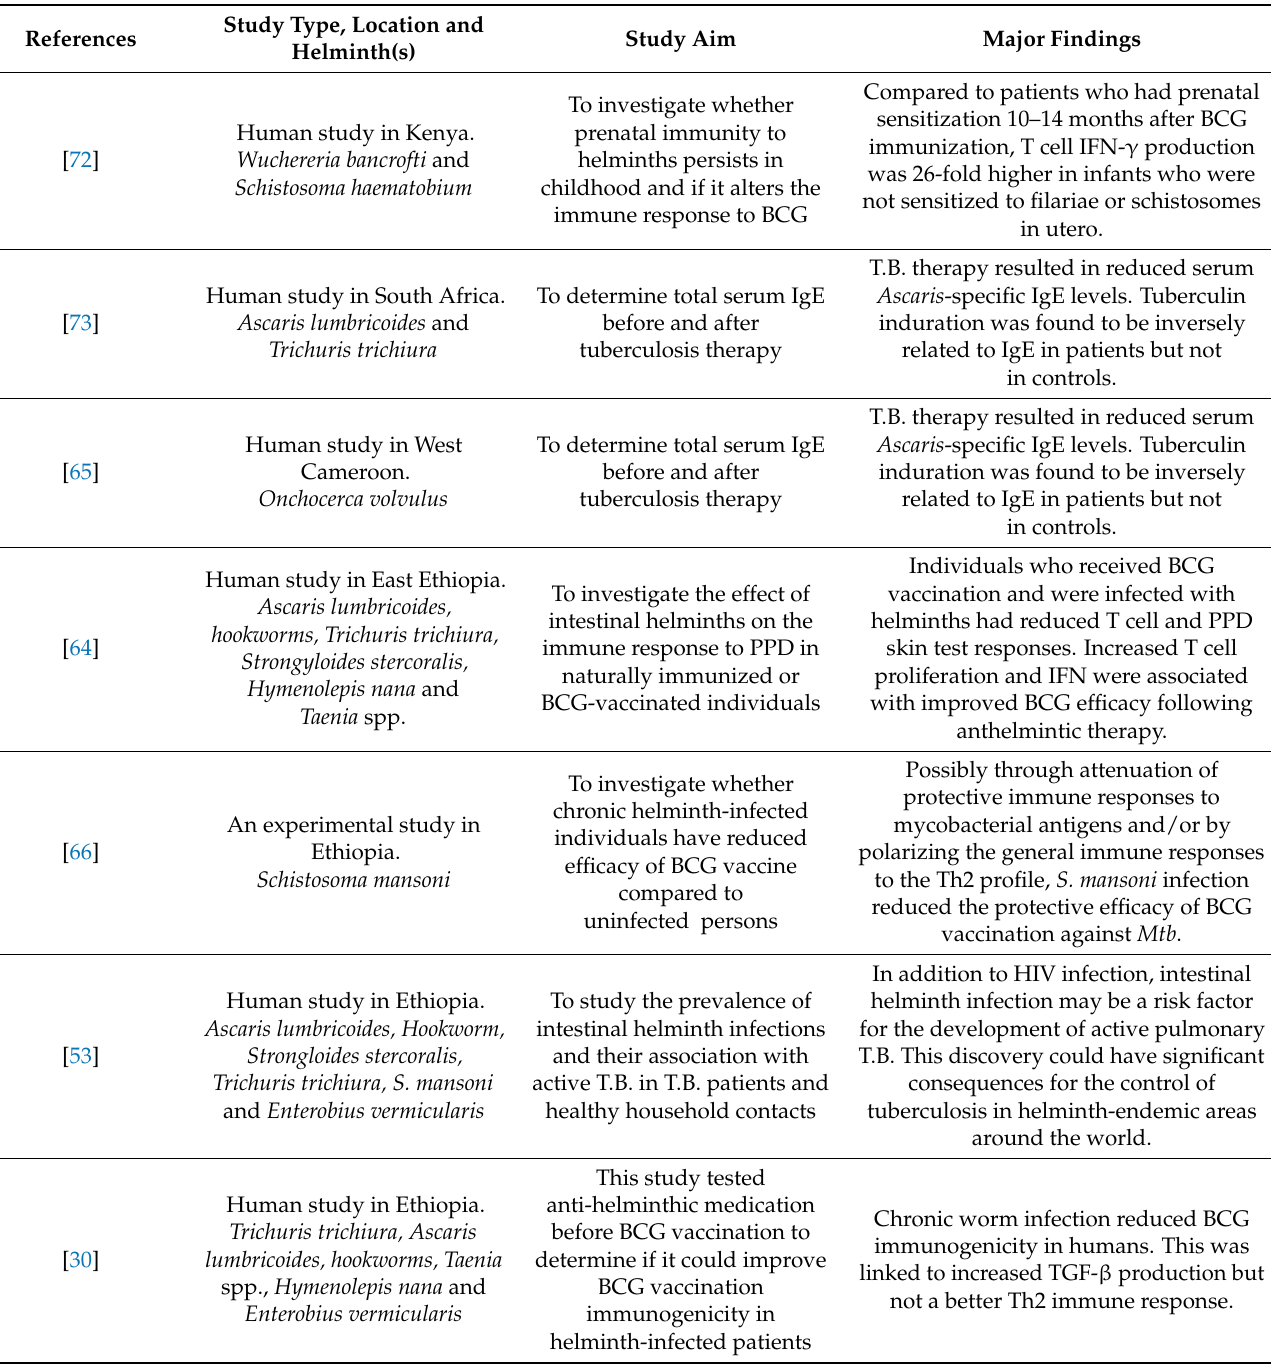
Table 1. Summary of experimental and human studies focusing on helminth and tuberculosis